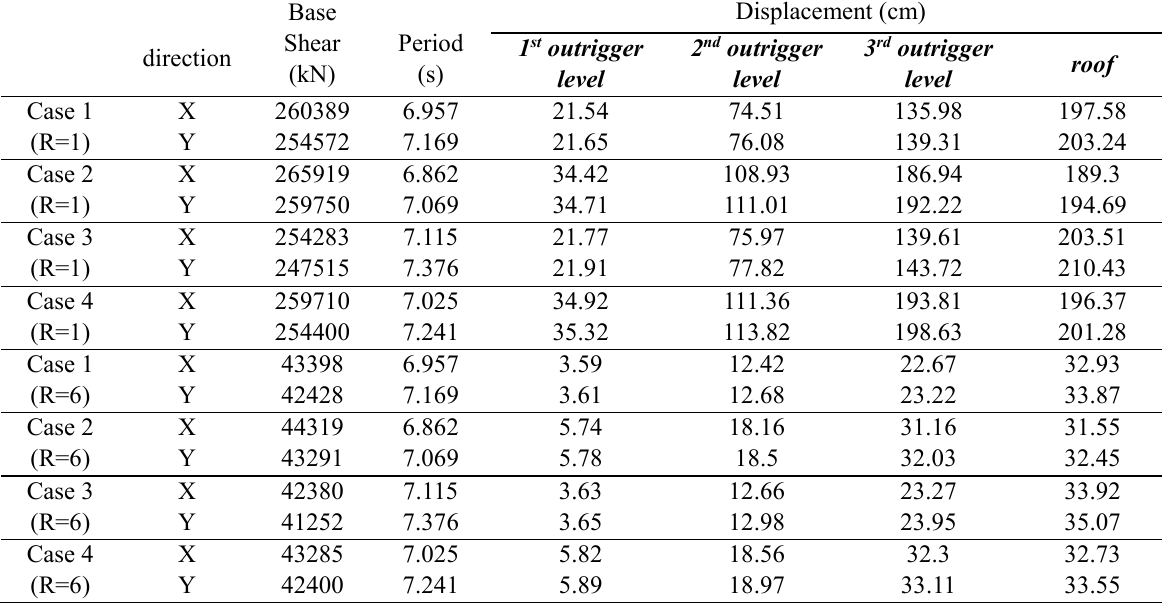
Base shear, Periods, and